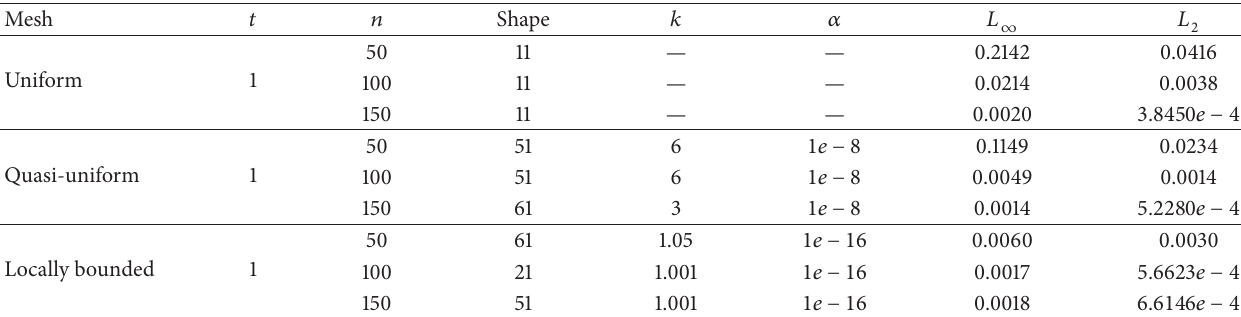
Figure 2: The plot of exact and approximate solutions of Example 5 with 50 uniform, quasi-uniform, and locally bounded nodes (resp., (a)–(c)). Table 1: The results of Example 5 with different number of nodes and different mesh distribution.